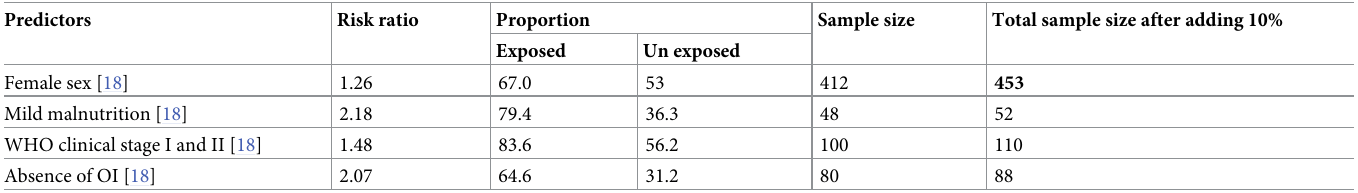
Table 1. Sample size calculation to assess the recovery rate and its predictors among under-nourished HIV positive adults treated with ready-to-use therapeutic food at Debre Markos Referral Hospital, Northwest Ethiopia, 2018. (CI:95%, Power = 80%). Predictors Risk ratio Proportion Sample size Total sample size after adding